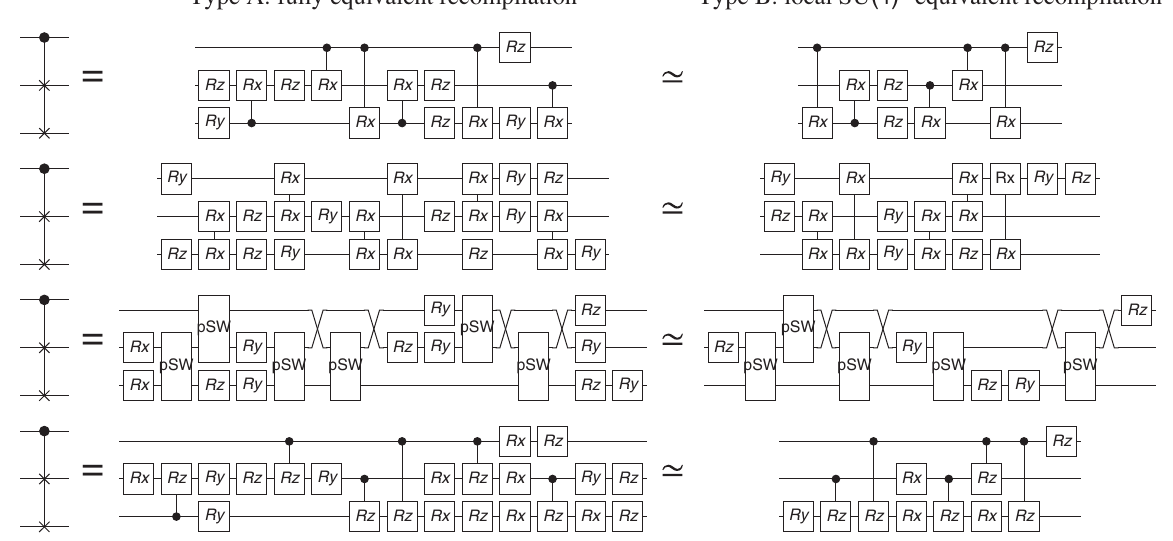
FIG. 7. Recompiling the controlled- SWAP gate into hardware-native gates. In all circuits the last R z rotation gate on the control qubit can be removed as it commutes with the controlled- SWAP gate and can be merged with the basis transformation of the ancilla qubit (Hadamard gate) immediately prior to measurement in Fig. 1.